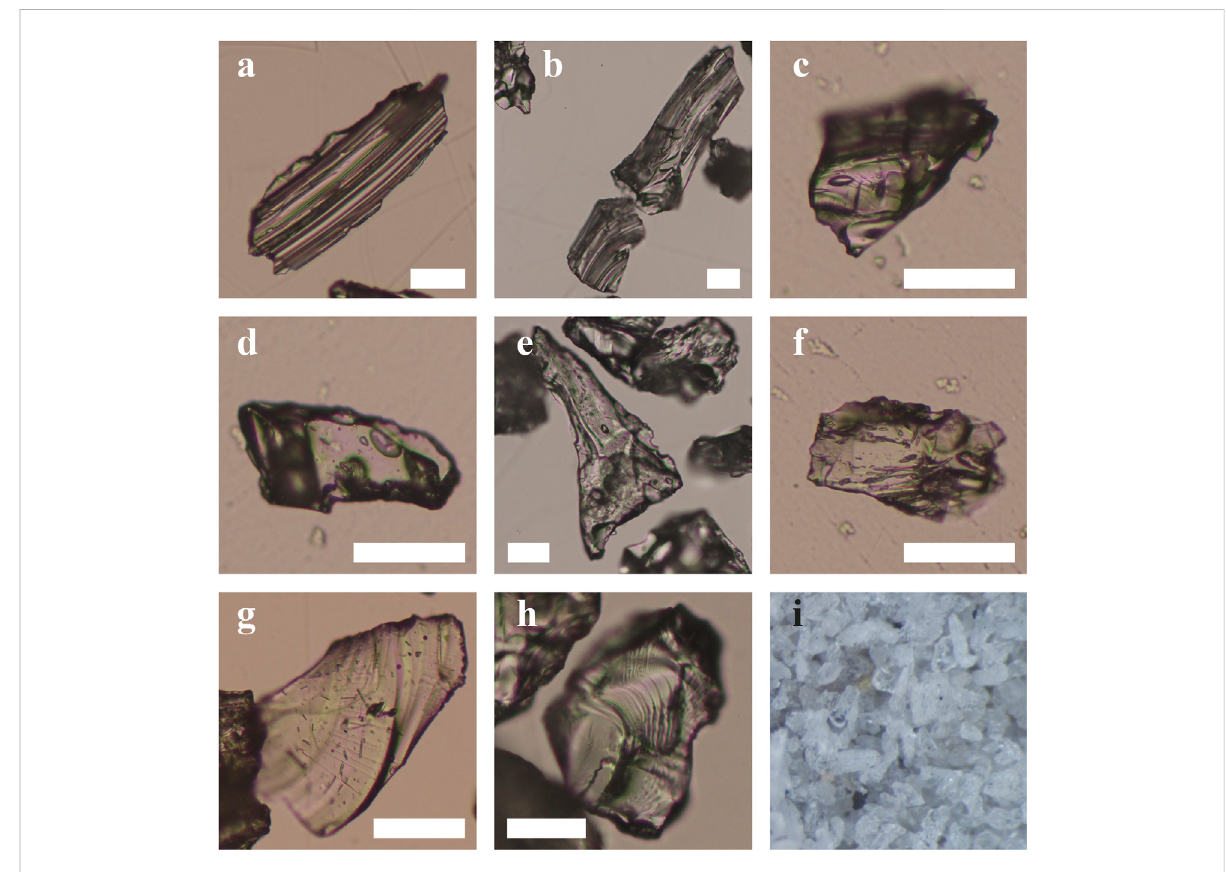
FIGURE 4 Transmitted light photographs of tephra types (all taken from the 63 – 125 µm size fraction). White scalebars represent 50 μ m. (A , B) pumiceous shards; (C , D) dense/blocky shards; (E) rare microlite-rich shard; (F) rare dense shard with distorted, possibly collapsing, vesicles; (G , H) shards with brittle stepped fractures on surfaces; (I) bulk sample of 63 – 125 µm size